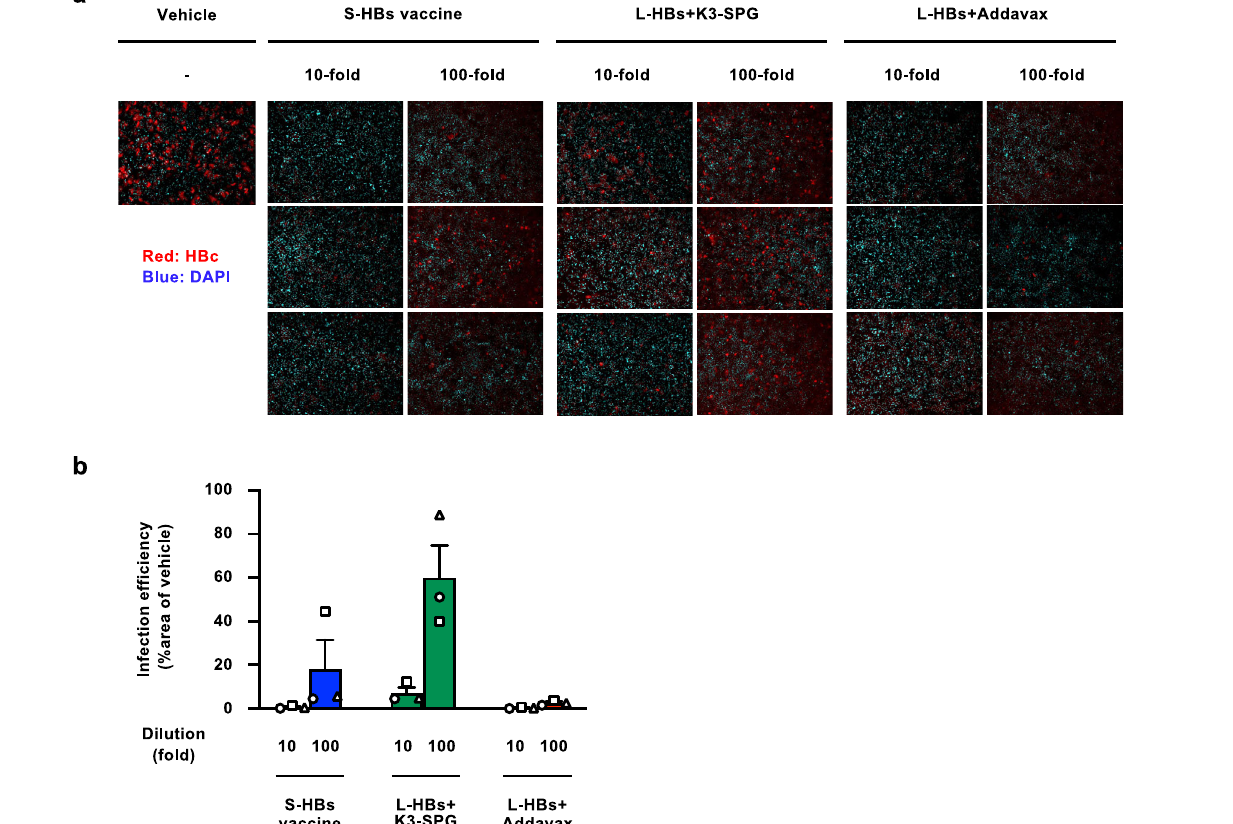
data of three animals in each group are indicated. b The infection ef fi ciencies of HBVcc after treatment with plasma samples of rhesus macaques were evaluated. The relative fl uorescence intensities of HBc-positive cells in each image were measuredandindicatedasthepercentagesofthevehicletreatment.Themean±SE of three animals in each group is indicated. Source data are provided as a Source Data fi